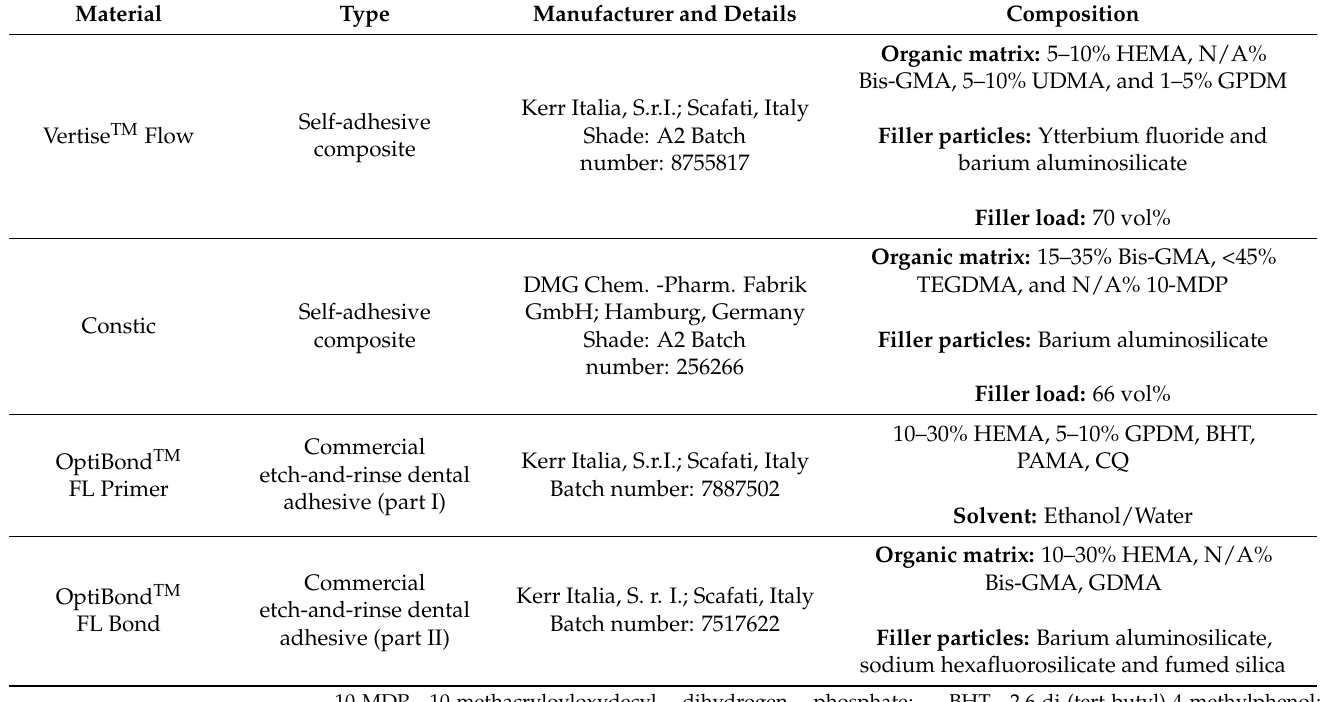
Table 1. List of self-adhesive composites and dental adhesives used and their chemical compositions, according to information retrieved from the manufacturers and safety